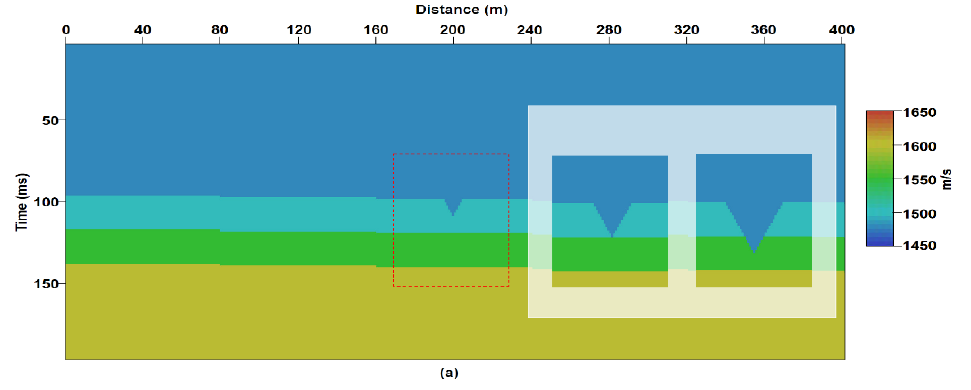
Figure 3. Numerical imaging results: ( a ) input velocity model of the flat layered subsurface; ( b ) RTM image of the flat model.